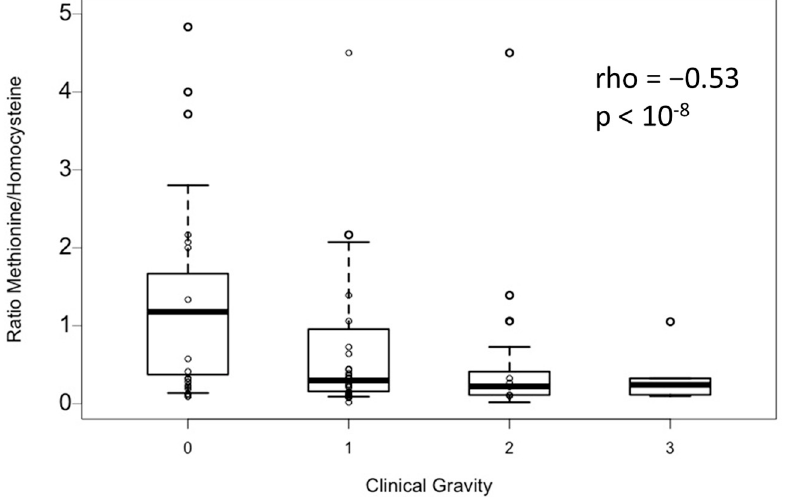
Figure 3. Methionine to Homocysteine ratio according to clinical severity. Groups are based on the severity of their clinical symptoms (based on Peripheral Neuropathy Disability (PND) score: level 0: no symptoms; level 1: paresthesia or PND I; level 2: gait disorders or PND II; level 3: thrombosis or combined subacute degeneration of spinal cord or PND III or IV. p -value and rho were obtained by non-parametric Spearman rank test. Data are expressed as median ± IQR.